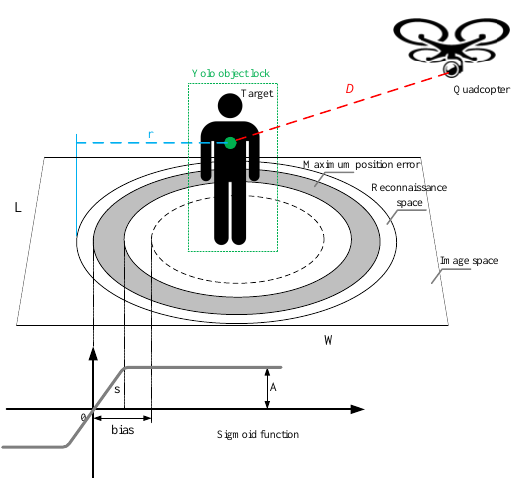
Figure 5. Target locking schematic framework. Figure 6 illustrates the operational flow of the adaptive target identification system.